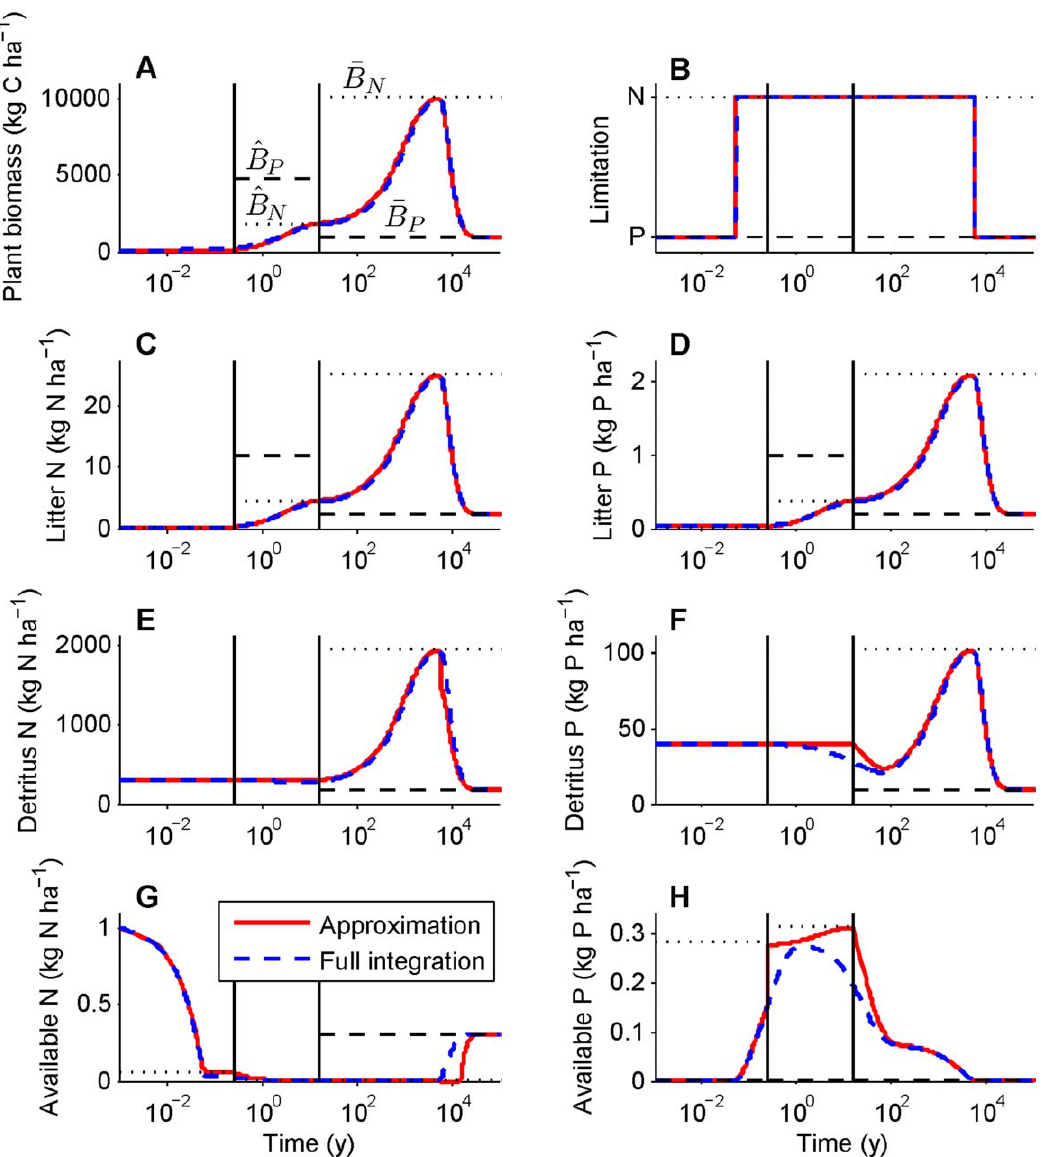
Figure 2. Fit of timescale approximation to full numerical integration. Parameters are as in Table 1, with no symbiotic N fixation. Both the approximation (solid red line) and the numerical integration (dashed blue line) began with biomass =300 kg C ha 2 1 , litter N and P=0.1 kg N ha 2 1 and 0.05 kg P ha 2 1 , soil organic matter (SOM) N and P=300 kg N ha 2 1 and 40 kg P ha 2 1 , and plant-available N and P=1 kg N ha 2 1 and 0.003 kg P ha 2 1 . Black dotted (N limited) and dashed (P limited) lines are quasi equilibrium and equilibrium values, displayed only for the relevant timescales. Vertical black lines indicate the timescale breaks: we used short timescale approximations to the left of the first black vertical line, intermediate timescale approximations between the two lines, and long timescale approximations to the right of the second line. Panels show (A) plant biomass, (B) which nutrient is limiting, (C) litter N, (D) litter P, (E) SOM N, (F) SOM P, (G) plant-available N, and (H) plant-available P. In this case net primary production begins P limited because there is an abundance of plant-available N, as from a small N fertilization, but becomes N limited within a couple weeks due to the large P:N ratio of inputs relative to plant demand and preferential P recycling. Plants remain N limited through succession and for thousands of years due to the preferential recycling of P and concomitant high loss ratio of dissolved organic N:P. At the long timescale plants become P limited because weathering inputs of P are negligible and dust P inputs are small. The time at which P limitation appears is controlled by the rock P weathering rate. See Fig. 4 for a different development trajectory. Note the logarithmic time axis. results. In the interest of space, we present the short timescale results in Appendix S1 except for the following essential points. All short timescale dynamics converge to globally stable quasi